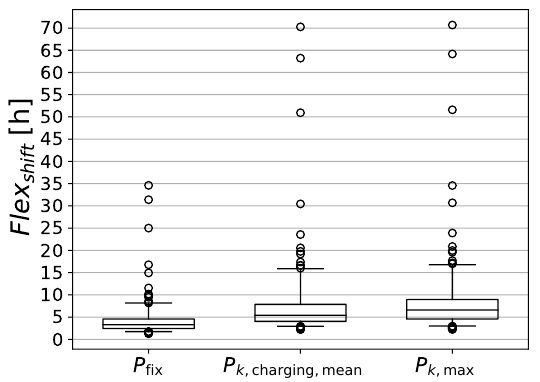
Figure 9. Flex shift potential for the office site.